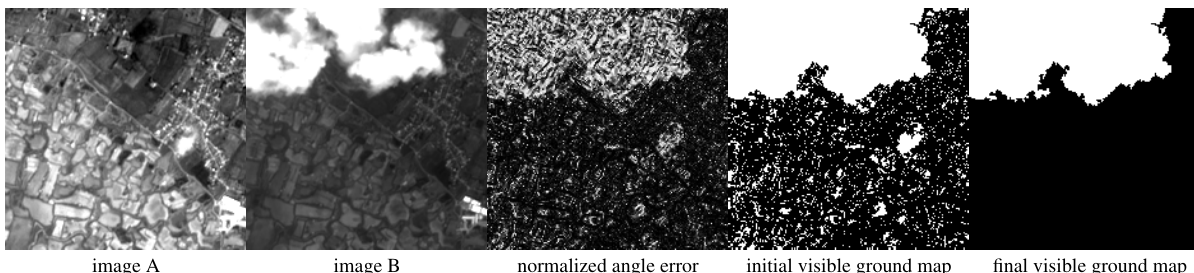
Figure 2. Two images to be compared and the intermediate and final result of the image matching method. In the normalized gradient orientation error map, black corresponds to zero error (same gradient orientation in both images) while white corresponds to the worst error (the gradient orientations have opposite direction). In the two ground visibility maps, black pixels correspond to visible ground while white corresponds to not visible ground. In the initial ground visibility mask one can see some “ground holes”, that is small white spots surrounded by black pixels. Those ground holes are filled for the final ground visibility mask. In this simple example with only two images, a common mask can be produced, and the zones that do not match are declared as not visible. However, when more images are included in the series, zones that are not at first detected as visible in the first image might match with other images in the series and therefore be declared as visible. This shows the relevance of the third hypothesis of the method: each zone should be visible at least twice in the time